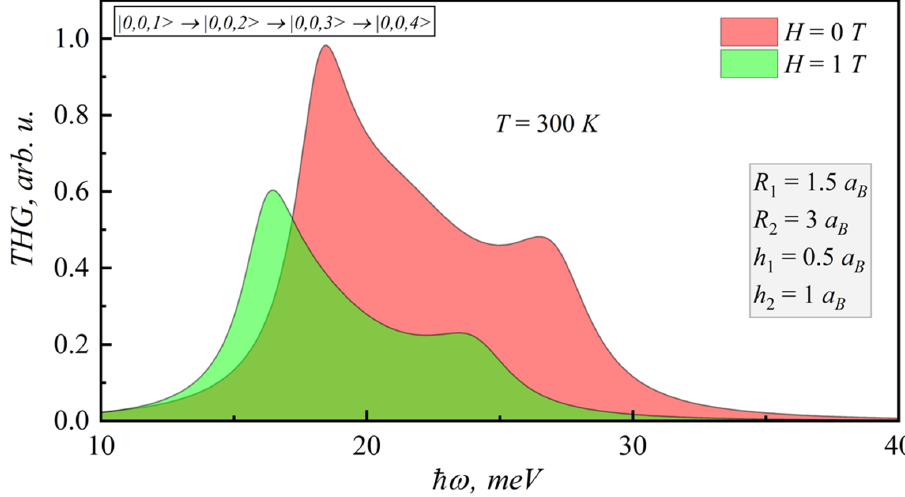
Figure 11. Dependence of THG coefficient on photonenergy for different magnetic fields.